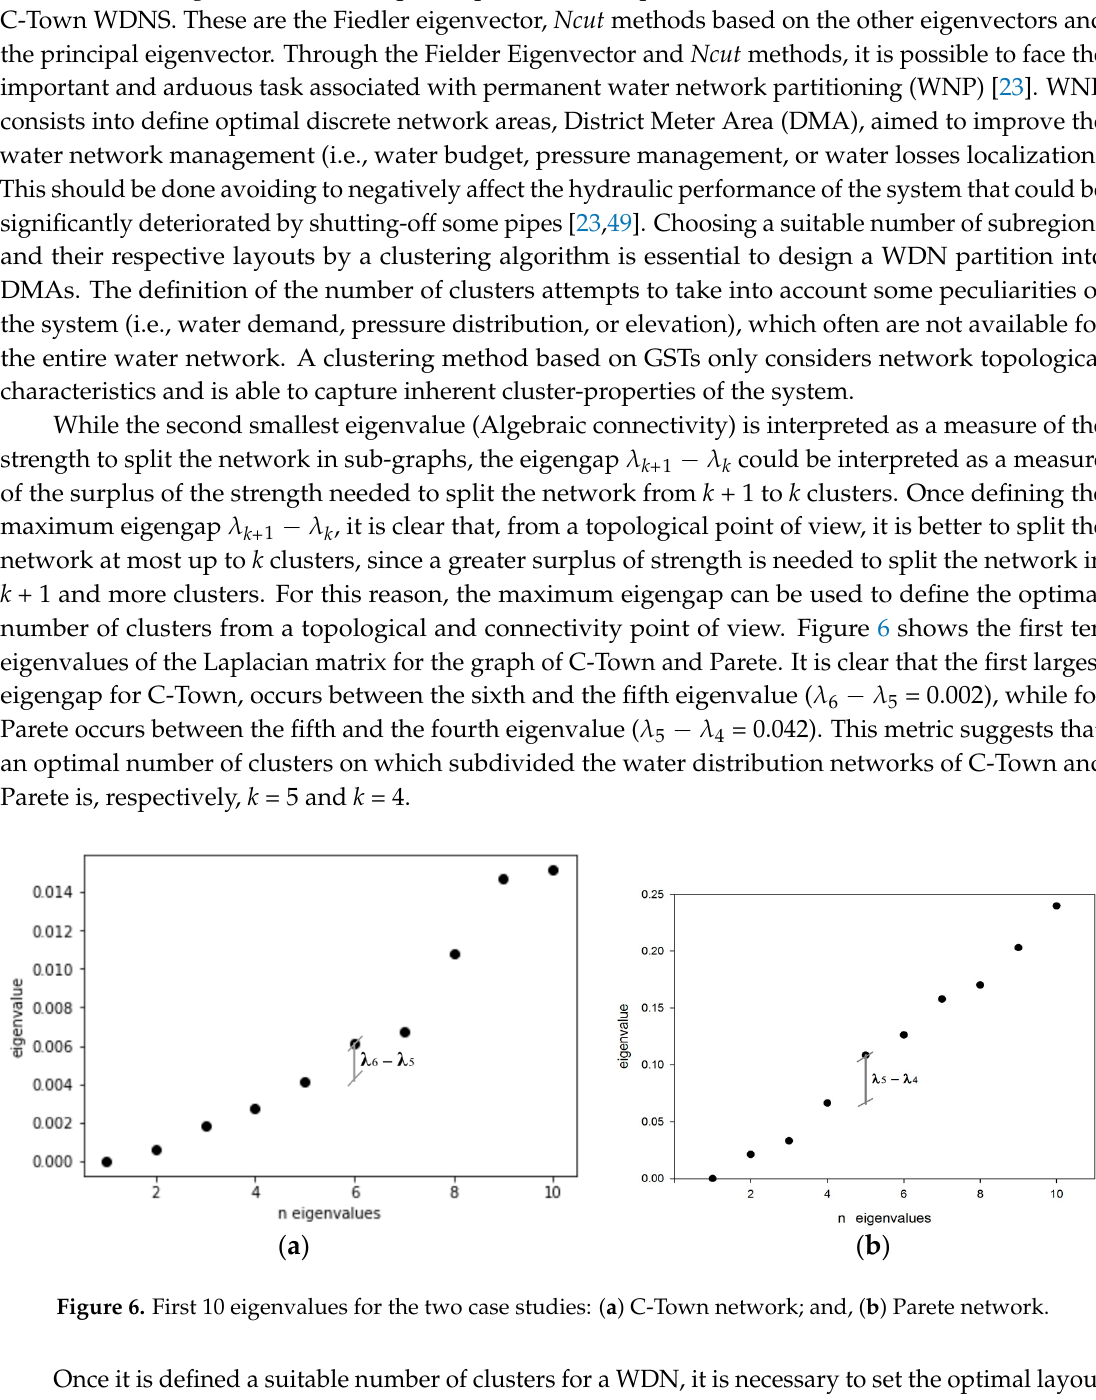
( b ) Figure 7. Fiedler eigenvector v 2 coordinates for the two case studies: ( a ) C-Town network; and, ( b ) Parete network. In case of the optimal number of clusters (defined by the maximum value of the eigengap) is higher than two, then the first clustering configuration obtained as outcome of the Fiedler eigenvector v 2 , can be used as input for a recursive bisection process. That is, for each cluster, the Fiedler eigenvector v 2 can be computed for the next clustering up to reach the targeted number of clusters. This network bisection can also represent a starting layout for other recursive algorithms that require an initial random choice of the clustering layout. Another GST based powerful tool for the optimal clustering layout of a water distribution network, is the Ncut spectral clustering [33], already explained in the Eigenvector techniques section, based on the use of other eigenvectors further than v 2 . Figure 8 shows the optimal clustering layout through Ncut spectral clustering. The results are given for a number of k = 4 clusters for Parete and k = 5 clusters for C-Town, according to the optimal number of